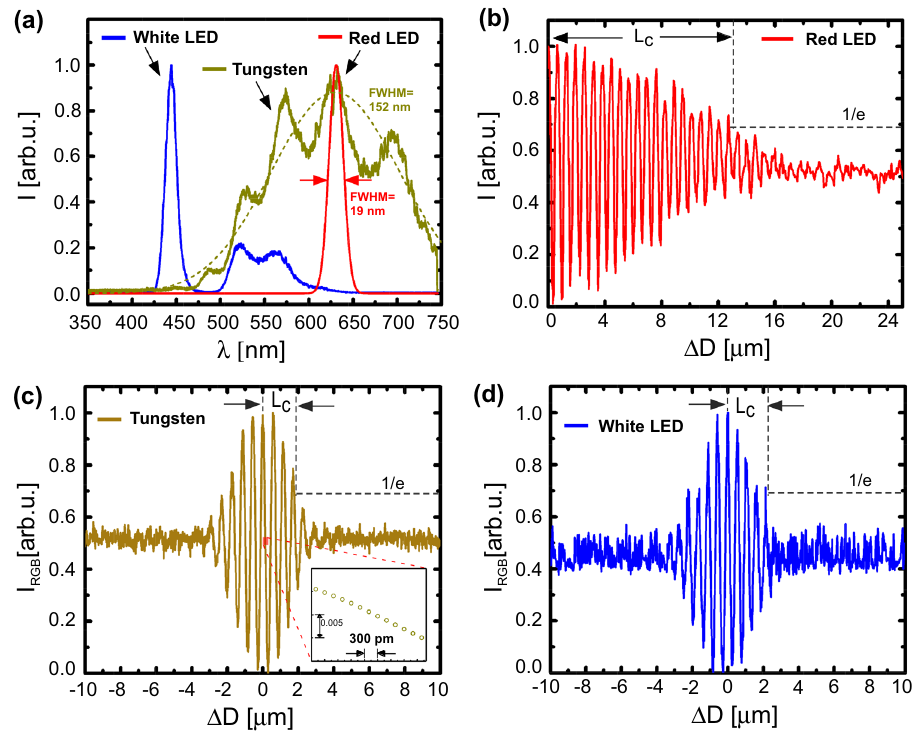
Figure 4. ( a ) Measured spectra of three different light sources. Experimental interferogram of ( b ) red LED, ( c ) tungsten bulb and ( d ) white LED. The corresponding coherence length L c is labelled. Inset in ( c ) shows picoscale